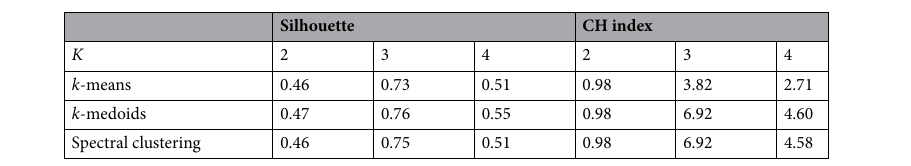
Table 2. Empirical cluster quality measures for cluster partitions obtained by proposed algorithms under varying number of clusters K . CH indices are scaled by 0.01 for demonstration purpose.